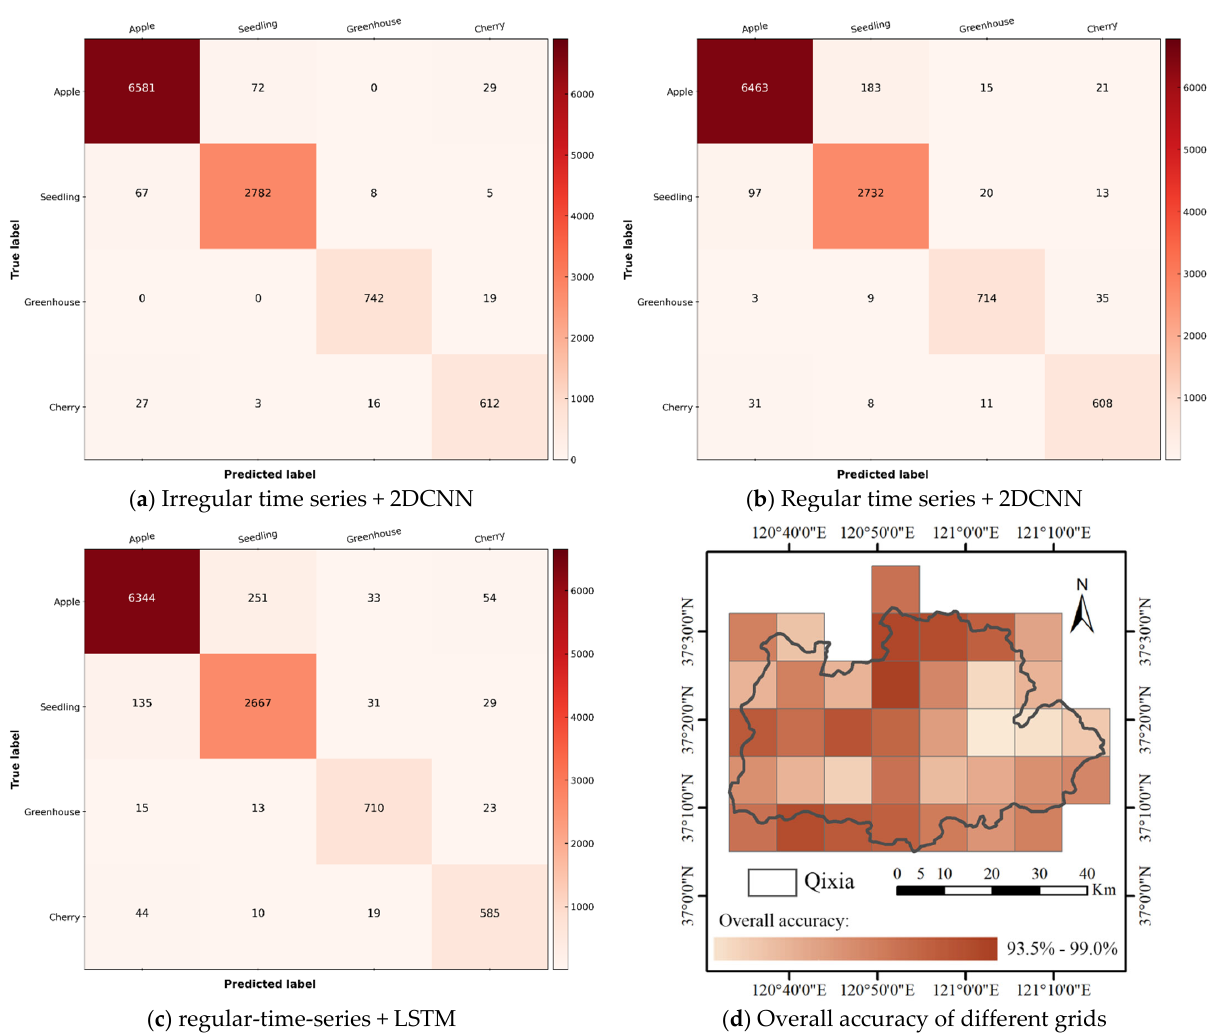
Figure 12. Accuracy evaluation of different experimental results. ( a ) Is the confusion matrix of the classification results with “irregular time series + 2DCNN”; ( b ) is the confusion matrix of the classification results with “regular time series + 2DCNN”; ( c ) is the confusion matrix of the classification results with “regular time series + LSTM”; ( d ) shows the overall accuracy of different grids.